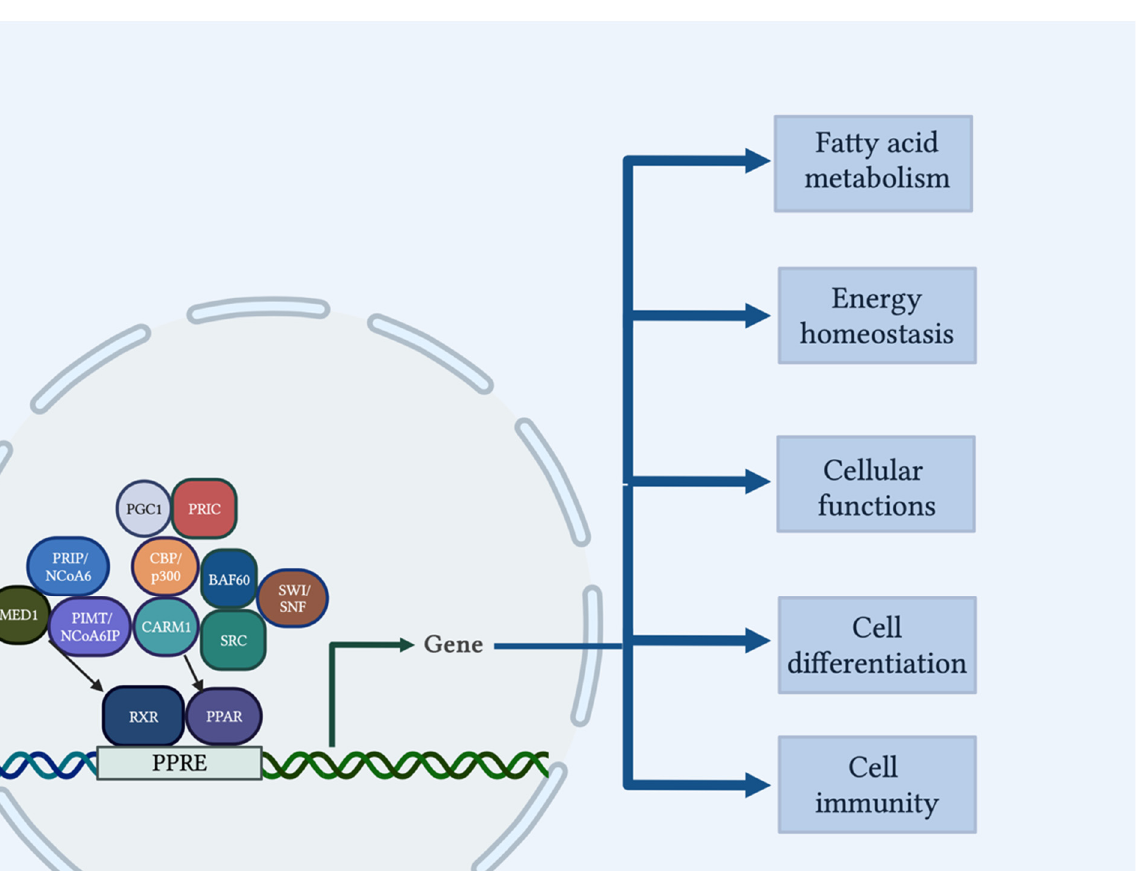
Figure 1. PRISMA flow diagram visually summarizing the screening process.